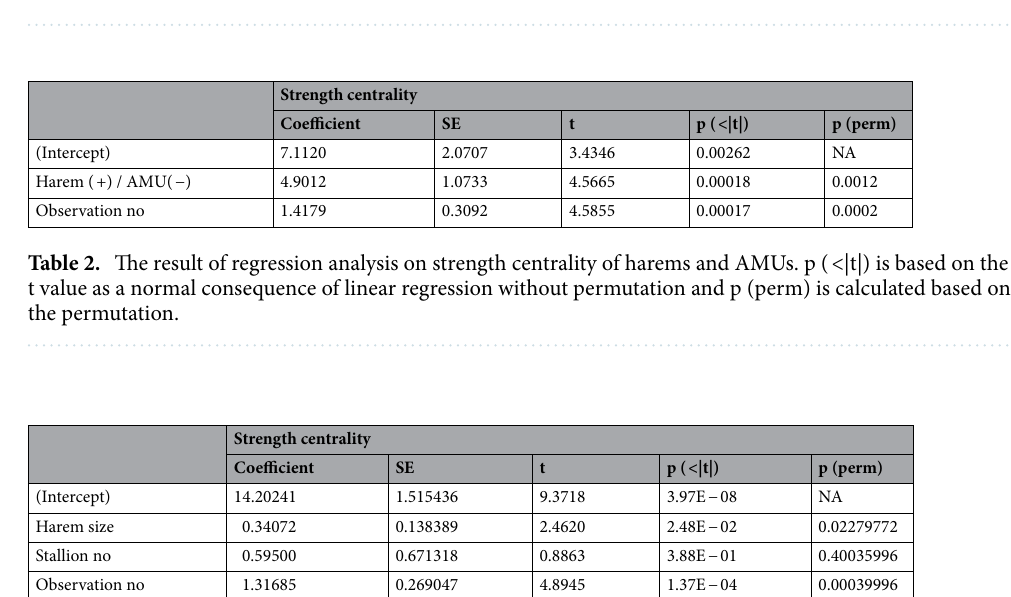
Table 1. The result of MRQAP-DSP (10,000 permutation). |size i − size j | and |centrality i − centrality j | is differences in unit size and centrality between units, type similarity is 0 when two units were same type (AMU or harem) and 1 when not, and location overlap is the proportion of the observation when two units were observed in the same zone.